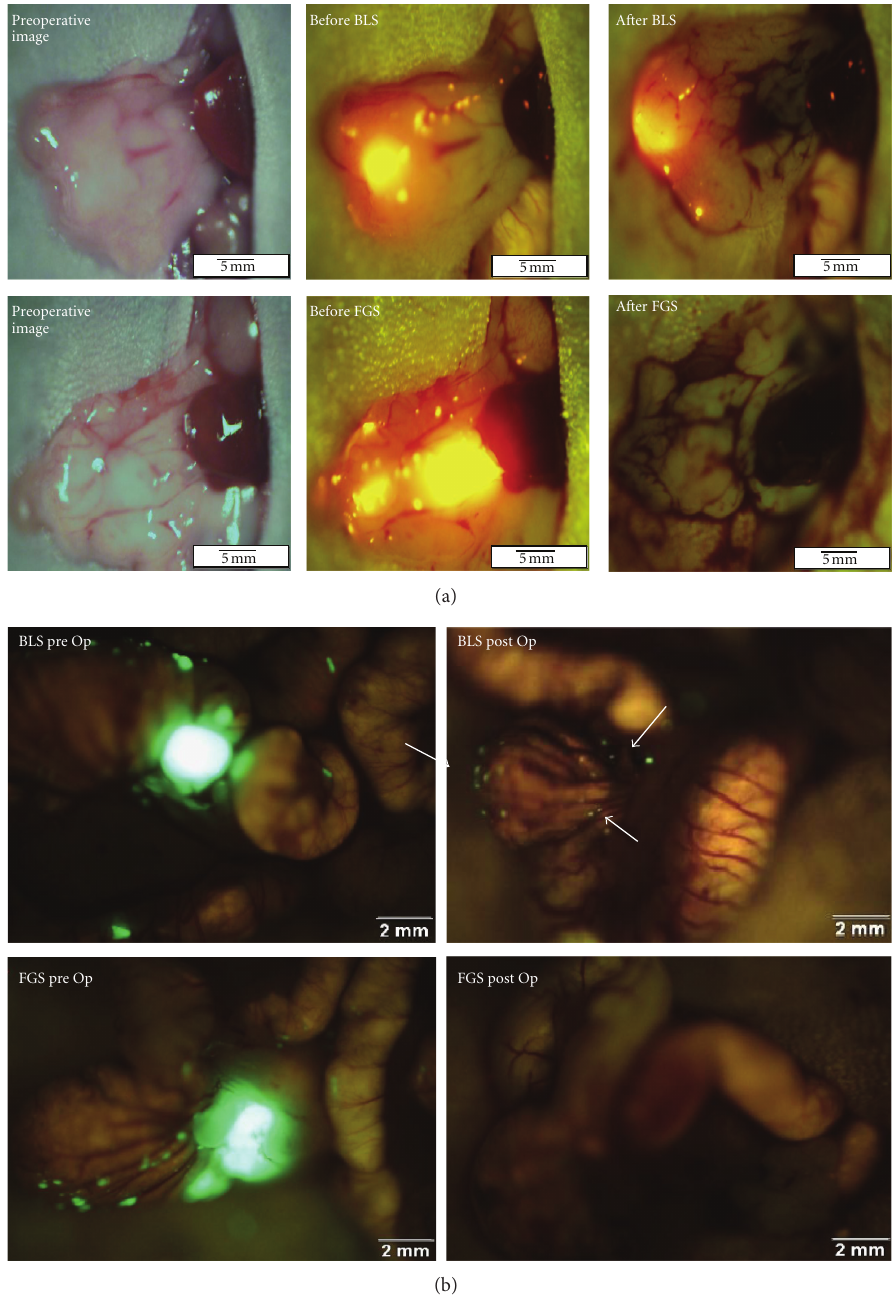
Figure 7: Surgical resection after fluorescence-guided surgery (FGS). (a) The top row are representative pre- and postoperative images of a mouse specimen from the bright-field surgery (BLS) group. The tumors were labeled with RFP. A tumor reduction of only 77% was achieved in the BLS group. The bottom row images are representative pre- and postoperative images of a mouse specimen from the FGS group. A significant improvement in tumor reduction was achieved in this group (98.9%, 𝑃 = 0.005 ). A complete surgical resection of pancreatic tumor with negative surgical margins was achieved in this mouse without requiring significant resection of the pancreas. (b) Representative pre- and postoperative images of a mouse from the BLS group (top panel) and the FGS group (bottom panel). The enhanced ability to visualize and identify tumor margins under fluorescence-guidance permitted a more complete resection. The tumors were labeled with GFP. All mice in the FGS group underwent an R0 resection while only 58% of mice in the BLS group had no evidence of residual fluorescent tumor on postoperative images (arrows in right upper panel) ( 𝑃 = 0.001 ) [4,